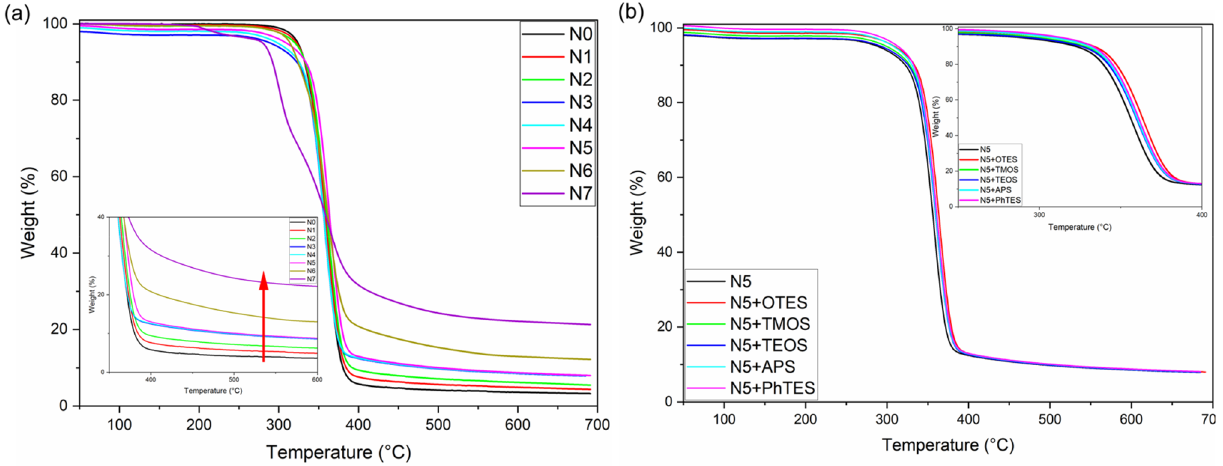
Figure 2. Influence of Ni/Cu concentration ( a ) and sol–gel coating, ( b ) on the ultra-light weight Ni/Cu coated polyester fibrous